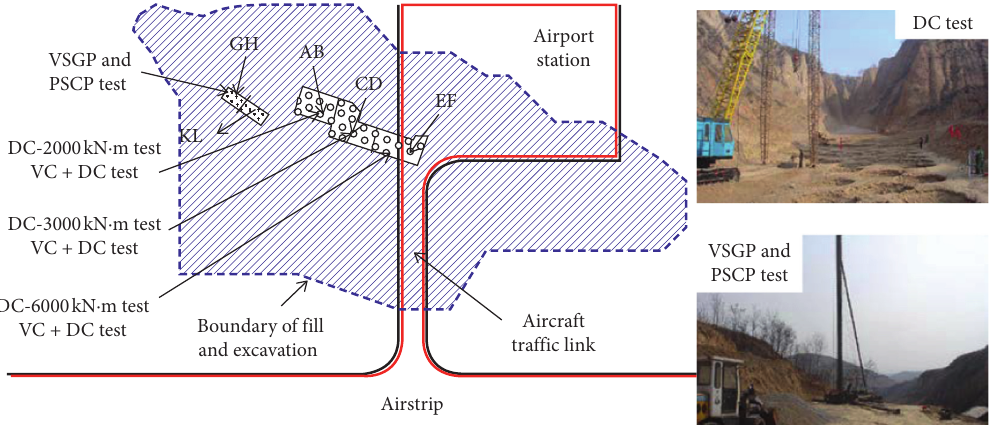
Figure 3: Reinforcement methods for the deep loess foundation.